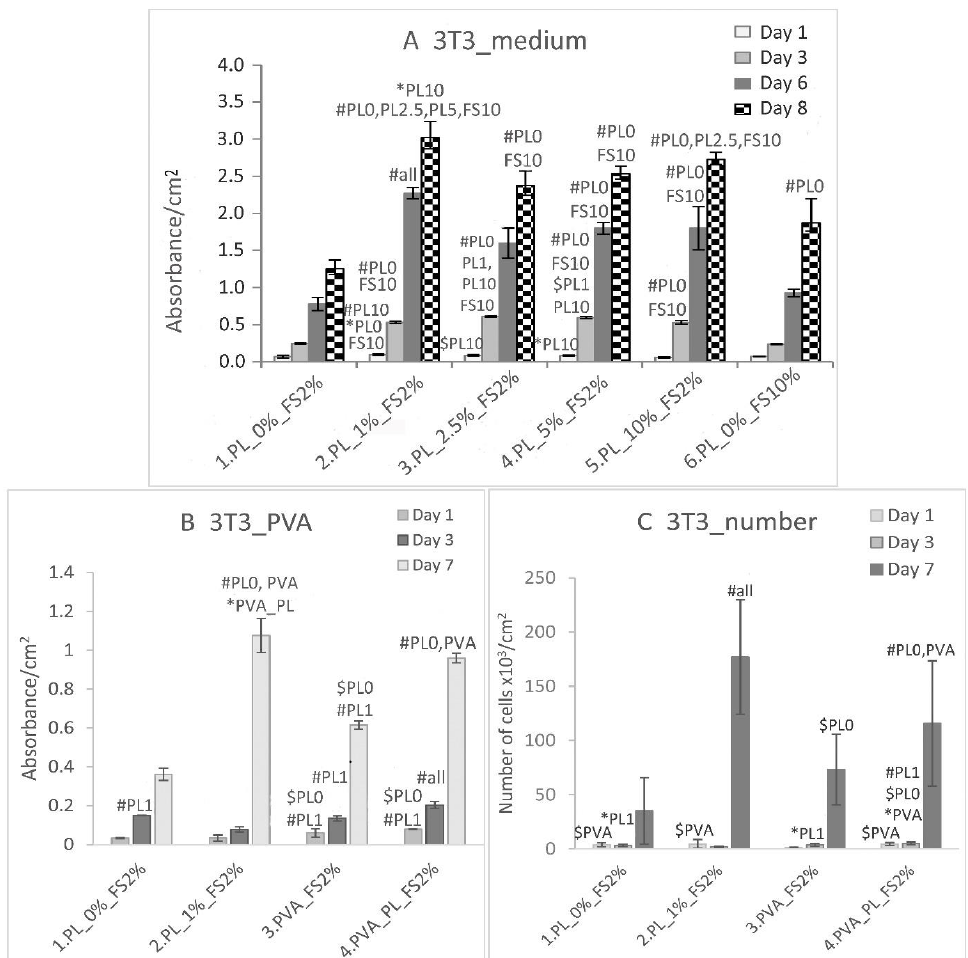
Figure 10. Viability of the 3T3 fibroblasts in the DMEM medium with 2% of FS supplemented with 0, 1, 2.5, 5 and 10% PL, and in the DMEM medium with 10% FS ( A ); viability of the 3T3 cells ( B ) and cell density of the 3T3 cells ( C ) in the DMEM with 2% FS and with 0 and 1% PL, and in the DMEM with 2% FS with PVA and PVA–PL nanomats. Evaluation as performed on days 1, 3, 6 and 8 following seeding ( A ) and on days 1, 3 and 7 following seeding. The data are expressed as the mean ± SD, # refers to p < 0.001, $ to p < 0.01, * to p < 0.05.